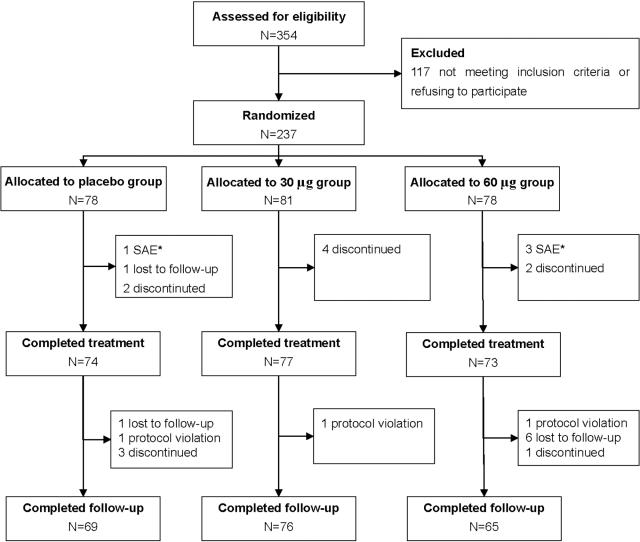
Summary of participants.Footnote: The numbers of SAE patients are those who discontinued treatment, while other SAE patients are not included in this figure.